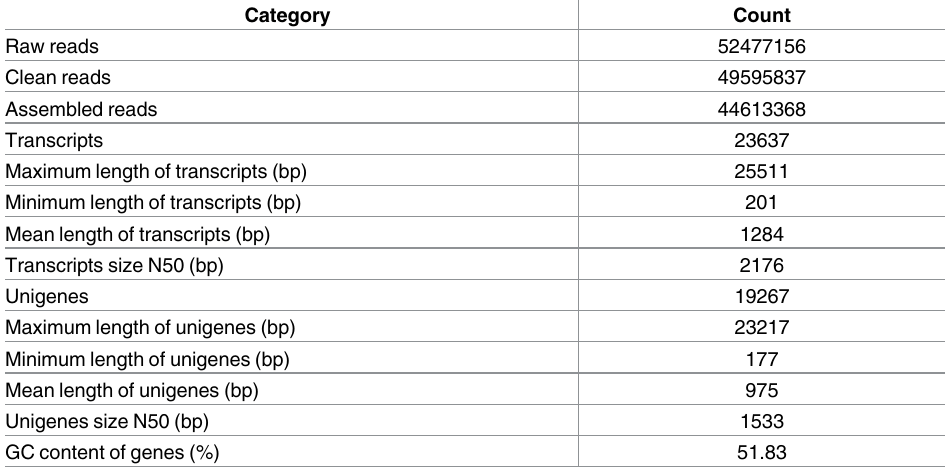
Table 1. Summary of transcriptome sequencing and assembly for P . litchii